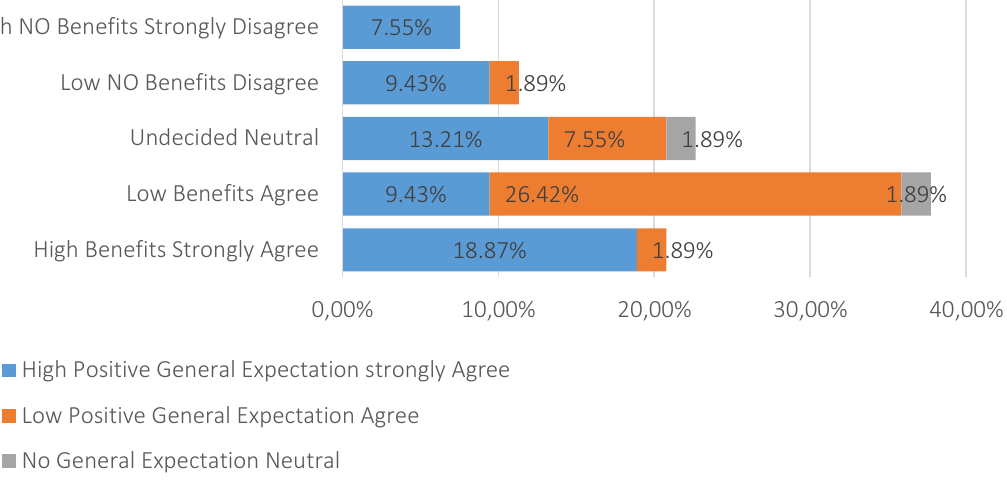
Figure 2. General expectations perceived and actual benefits derived